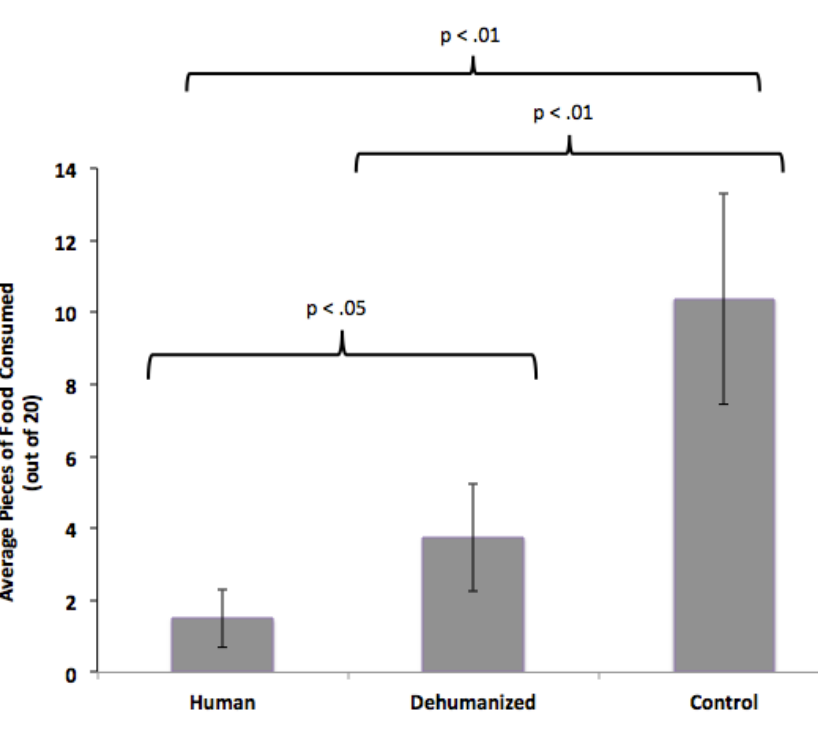
Figure 2 . Average amount of dry food consumed across experimental categories. Error Bars = ±